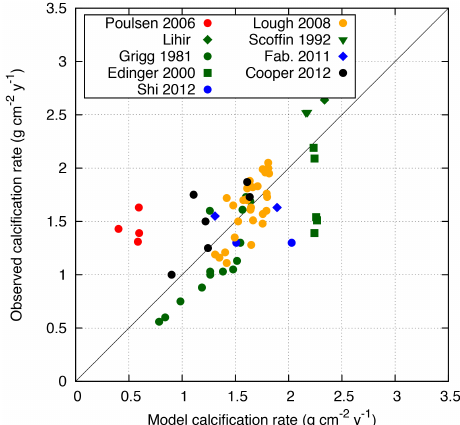
Figure 8. Comparison of observed and modelled calcification rates. The Lihir datum is the calcification rate reported for Lihir Island, Papua New Guinea, in Lough